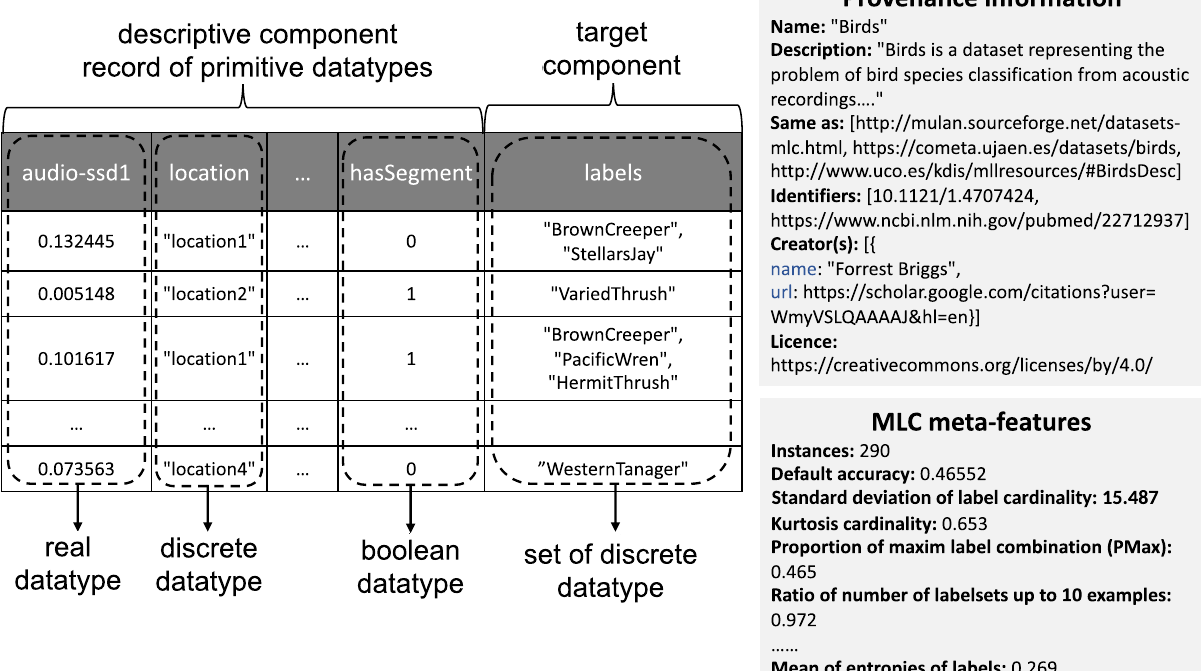
Figure 2. Semantic annotation of the Birds dataset 15 . We depict the dataset in tabular format on the left-hand side, where we also show the annotations of the different datatypes present in the dataset. In addition, we present the annotations of the available provenance information and a list of calculated MLC meta-features on the right-hand